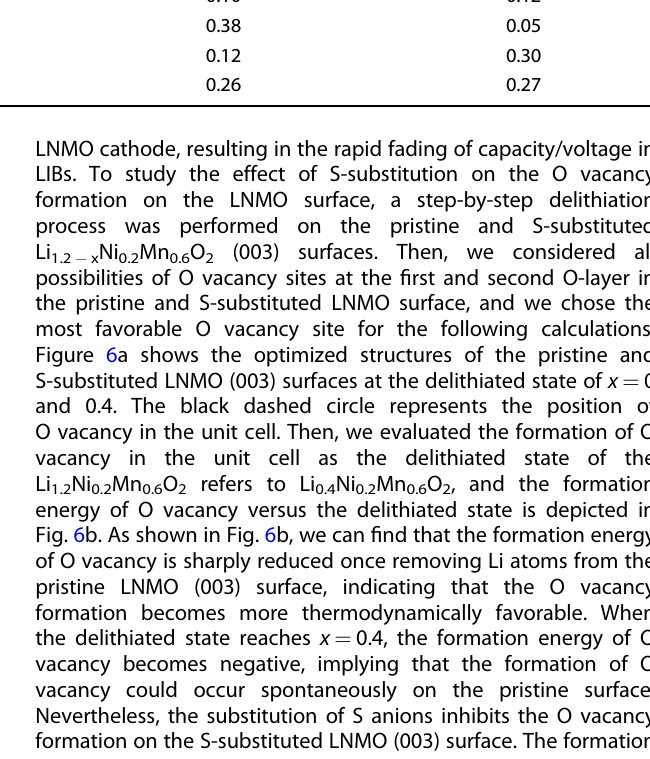
Table 2. The calculated magnetic moment of Ni on the pristine LNMO (003) surface at the delithiated state of x = 0.4 indicates that Ni atoms are + 3 oxidation state (~1.3 μ B ), while the Ni atoms on the S-substituted surface exhibit a + 4 oxidation state (~0.3 μ B ).